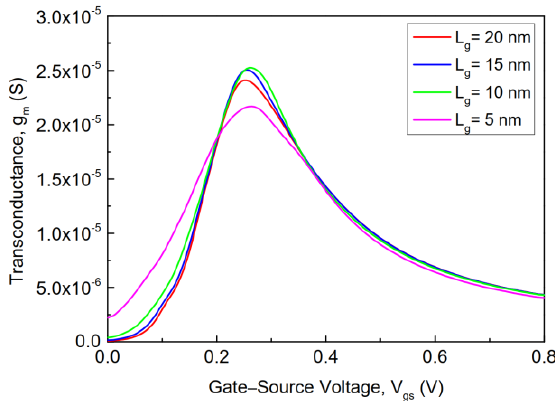
Figure 16. Transconductance as a function of gate – source voltage with different gate lengths at V ds = 0.05 V.